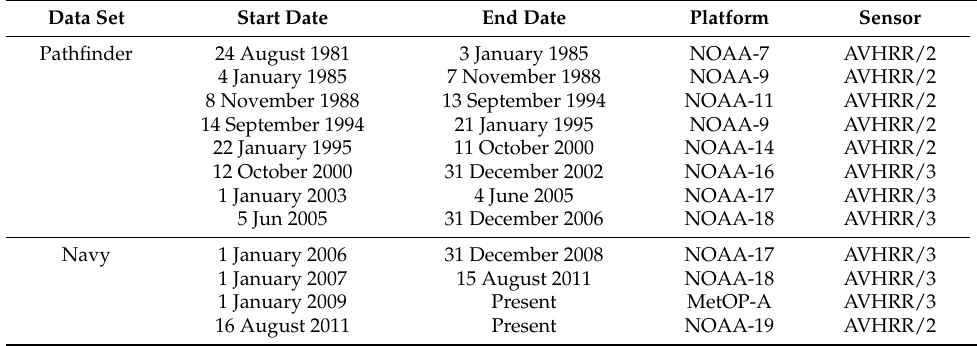
Table 2. Platform time spans of AVHRR inputs to the daily OISST data. From